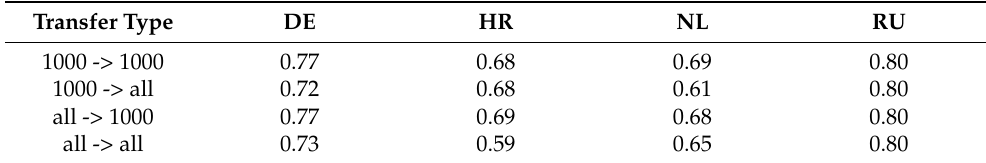
Table A1. Spearman’s correlation coefficients derived by MS-MiniLM model, transfer from English.